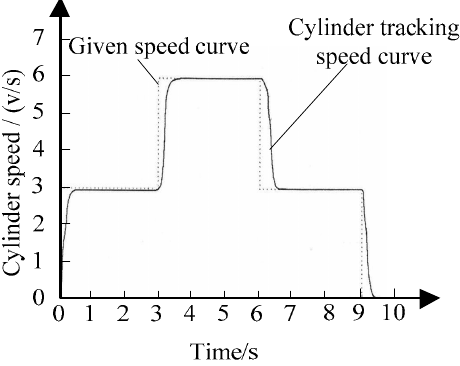
Figure 3. Velocity Mutation Tracking Curve.